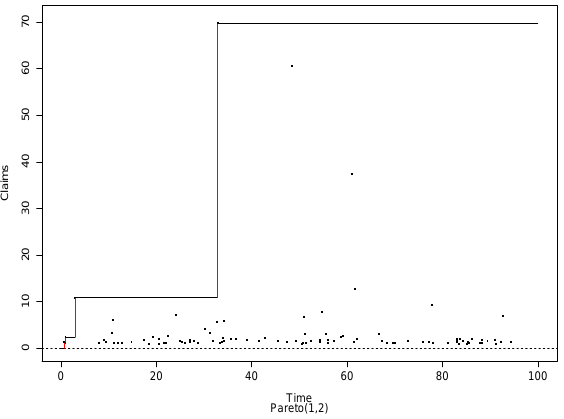
Figure 1. A schematic illustration of the largest claim reinsurance (LCR) reinsurance scheme with a Pareto(1,2) claim distribution. Black dots indicate claim amounts and red lines are the successive amounts liable for the reinsurance